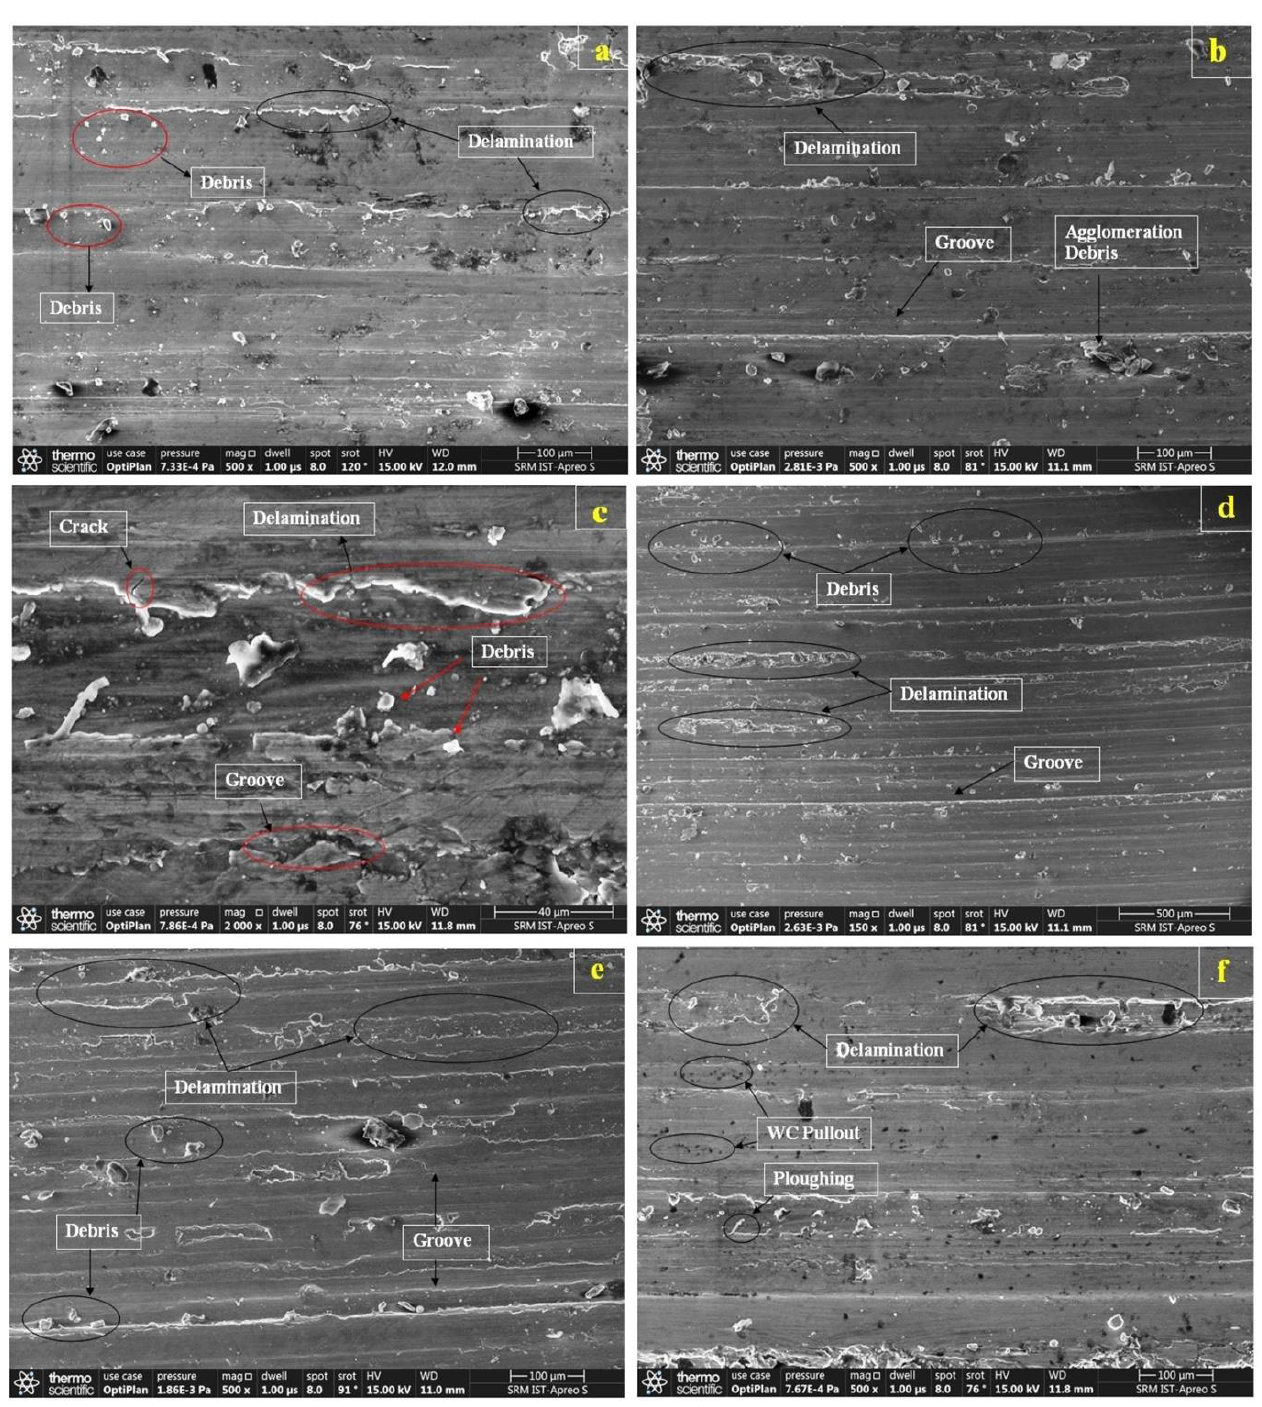
Figure 10. SEM micrographs of worn surfaces of Al7075-WC composites with sliding distance of 2000 m: ( a ) non-aged at 10 N; ( b ) non-aged at 20 N; ( c ) non-aged at 30 N; ( d ) 250 °C aged at 10 N; ( e ) 250 °C aged at 20 N; ( f ) 250 °C aged at 30 N.